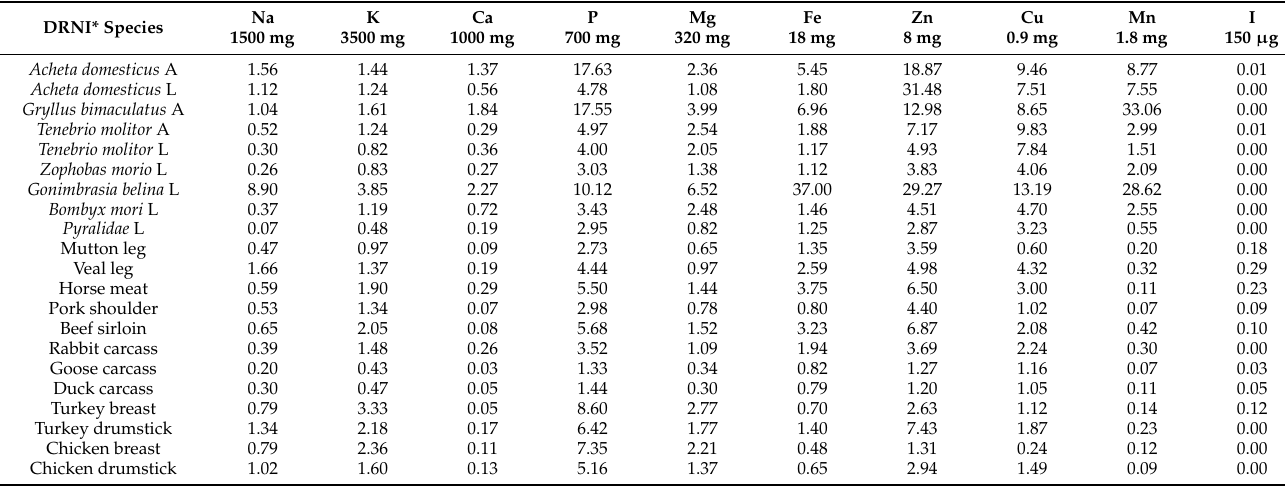
Table 7. INQ values of selected minerals following the demand of women (31–50 years old, bodyweight 45 kg, moderate physical activity) **.